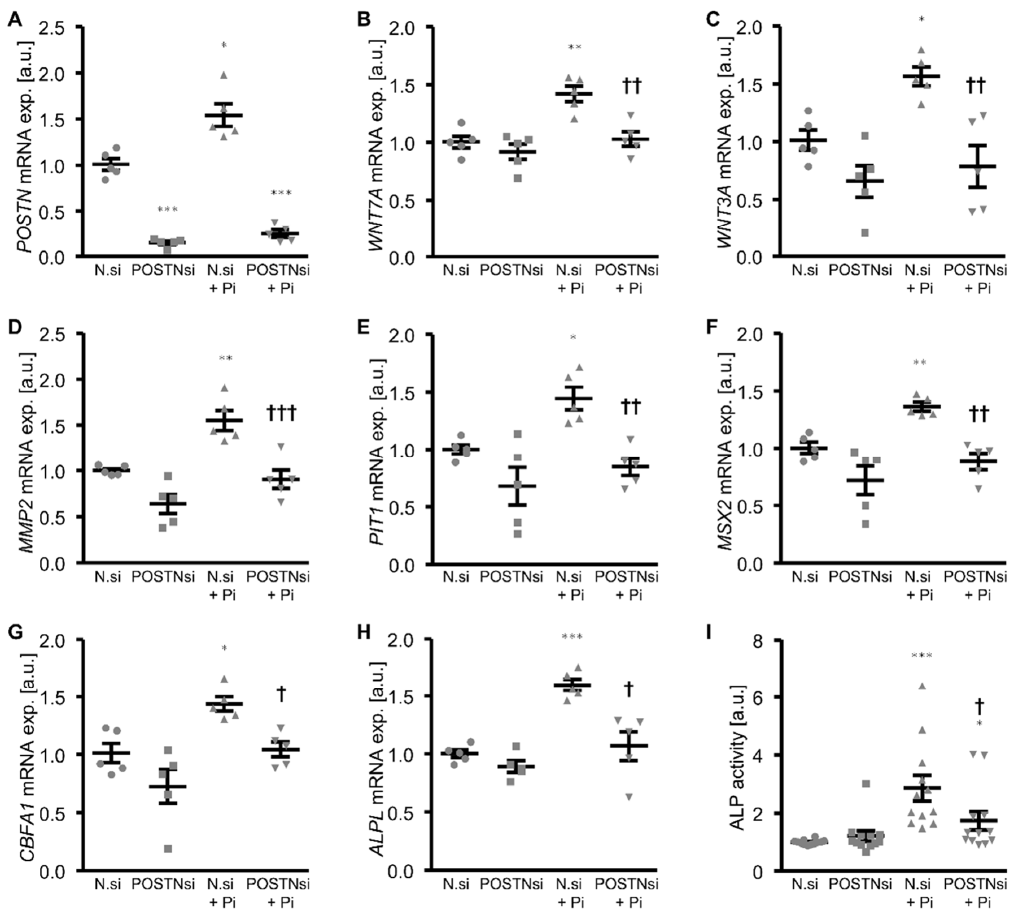
Figure 6. Silencing of periostin ameliorates phosphate-induced WNT/ β -catenin and osteogenic signaling in HAoSMCs. ( A – H ) Relative mRNA expression of POSTN ( A ), WNT7A ( B ), WNT3A ( C ), MMP2 ( D ), PIT1 ( E ), MSX2 ( F ), CBFA1 ( G ) and ALPL ( H ) in HAoSMCs transfected with negative control siRNA (N.si) or POSTN siRNA (POSTNsi) and treated with control or β -glycerophosphate (Pi). ( I ) Normalized ALP activity in HAoSMCs transfected with negative control siRNA (N.si) or POSTN siRNA (POSTNsi) and treated with control or β -glycerophosphate (Pi). * p < 0.05; ** p < 0.01; *** p < 0.001 (significant difference versus N.si group); † p < 0.05; †† p < 0.01; ††† p < 0.001 (significant difference versus N.si + Pi group).